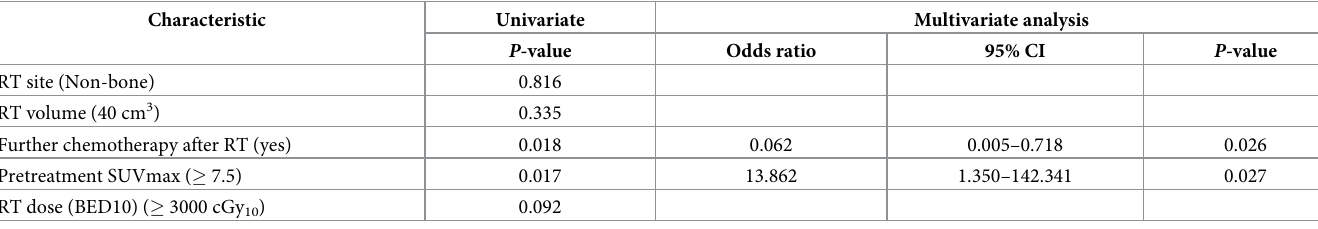
Table 6. Binary logistic regression analysis predicting reductions in SUVmax of � 70% after